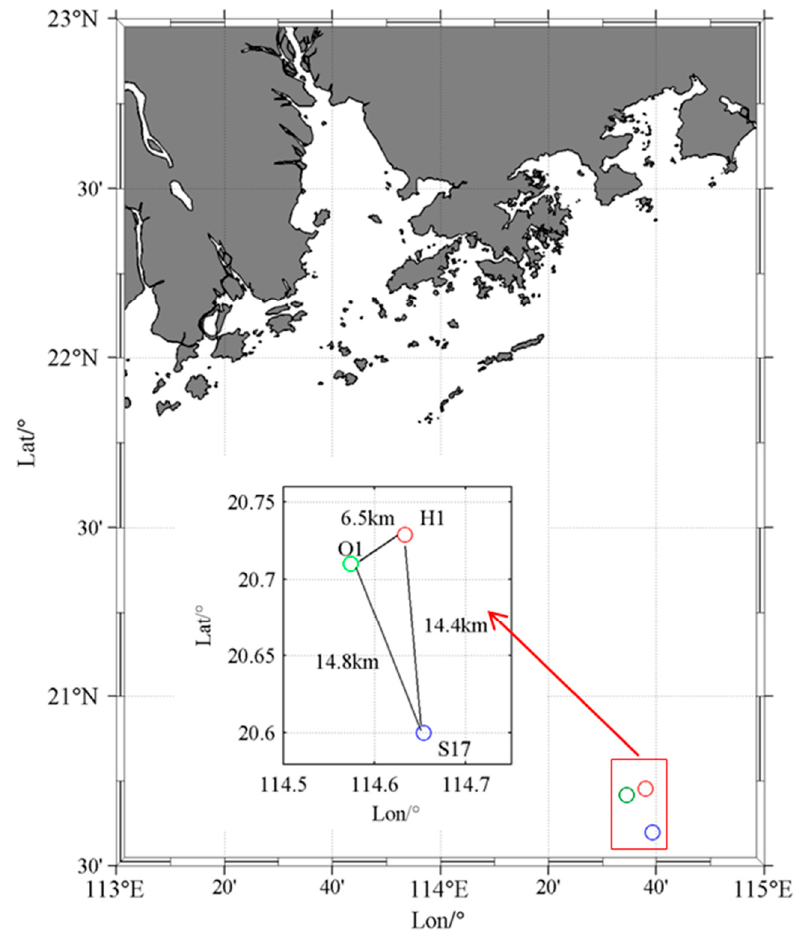
Figure 2. Location distributions of the three thermistor chains.